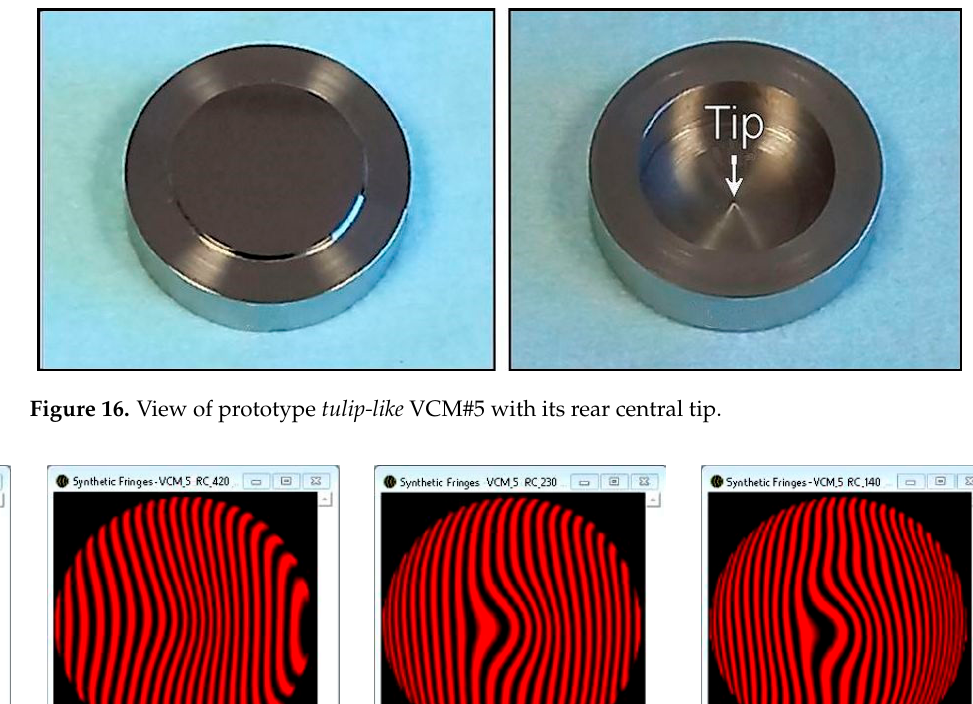
13 Figure 14. Tulip ‐ like VCM assembly. Figure 15. Actuator of the push force control system by Micro ‐ Contrôle Corp. 6.2. Results from Realization and Optical Testing Before the FEA optimization modeling presented in Section 4, a tulip ‐ like VCM was designed from the analytic plate deflection theory, plate alone, i.e., without taking into